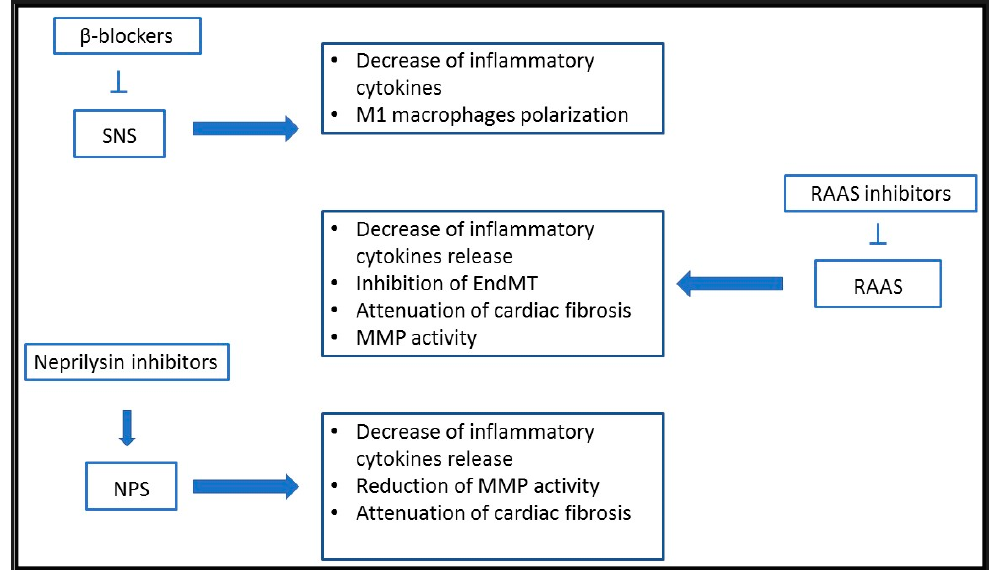
Figure 2. Immunomodulatory effects of commonly used heart failure drugs. Beta blockers reduce inflammatory cytokines release and M1 macrophages polarization. Each beta-blocker molecule can have others specific action in immunoregulation. RAAS inhibitors decrease the inflammatory cytokines release reducing matrix metalloproteinases (MMP) activity and inhibit the EndMT attenuating cardiac fibrosis. Sacubitril reduces inflammatory cytokines release and MMP activity attenuating cardiac fibrosis. Abbreviations: RAAS: renin-angiotensin-aldosterone system; MMP: matrix metalloproteinases; EndMT: endothelial to mesenchymal transition.